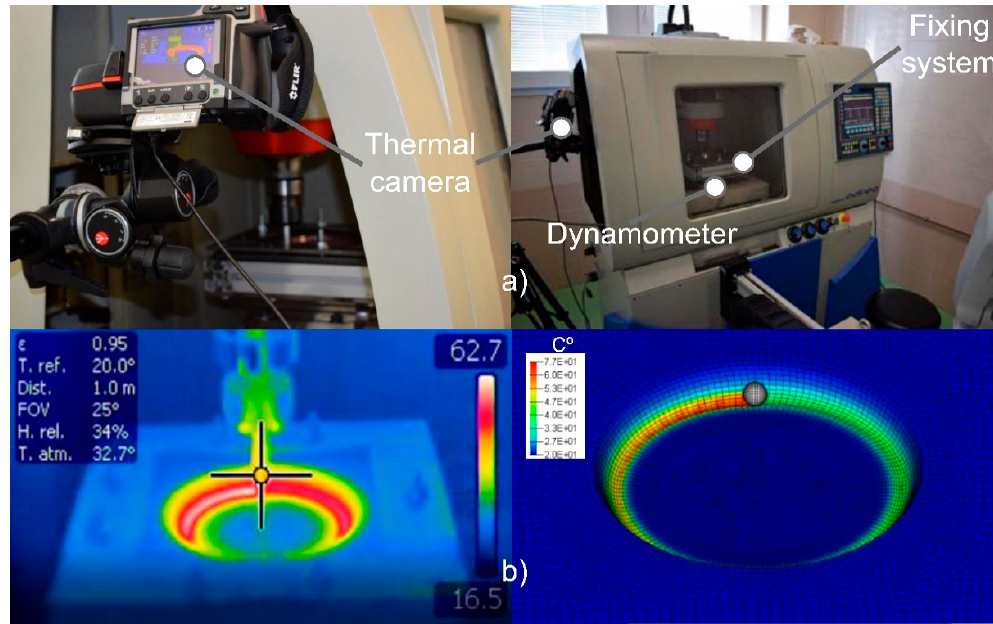
Figure 3. Experimental setup ( a ) and thermal correlation with numerical results ( b ).